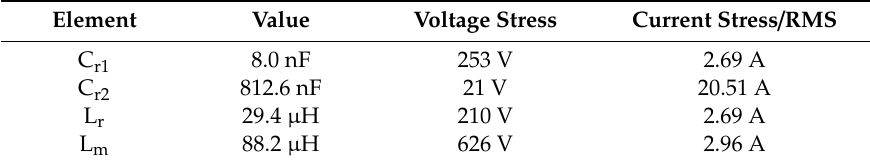
Table 3. Parameters of the resonant